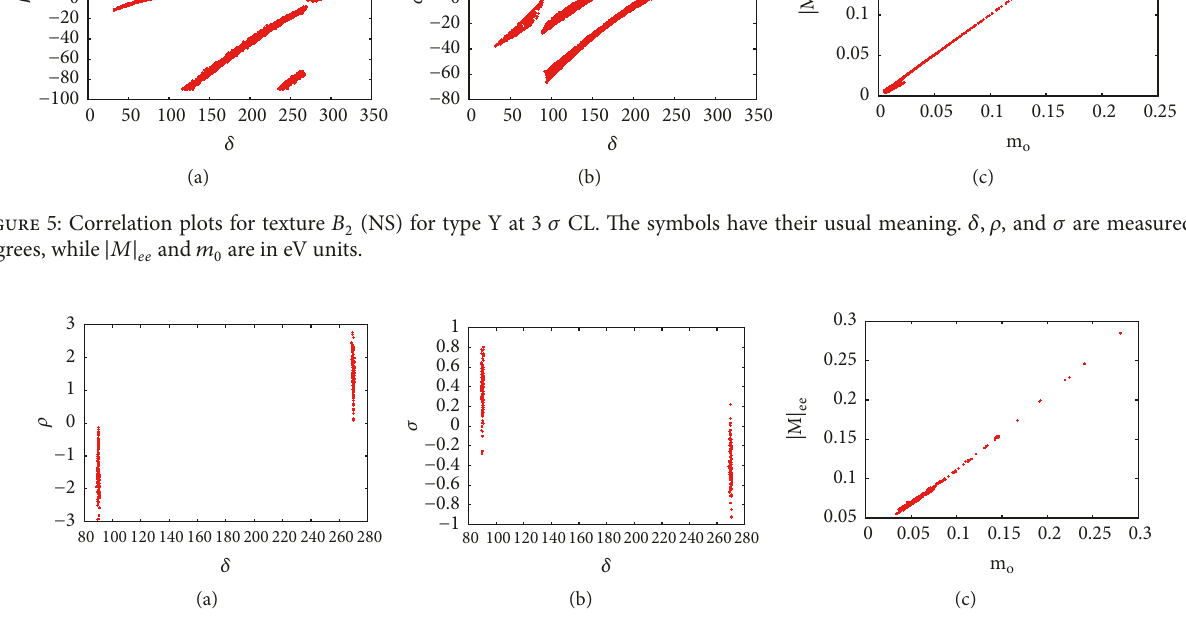
Figure 6: Correlation plots for texture 𝐵 2 (IS) for type Y at 3 𝜎 CL. The symbols have their usual meaning. 𝛿, 𝜌 , and 𝜎 are measured in degrees, while |𝑀| 𝑒𝑒 and 𝑚 0 are in eV units.